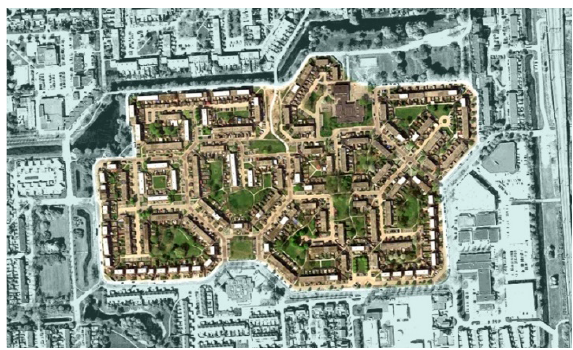
Figure 15. Tjalk: aerial map. Source: authors.